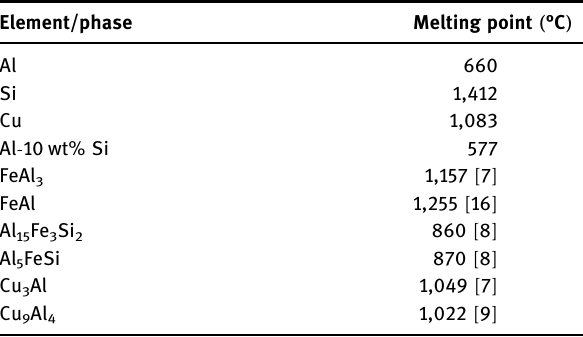
Table 5: Melting point of phases in Al – Si – Cu coating ( °C